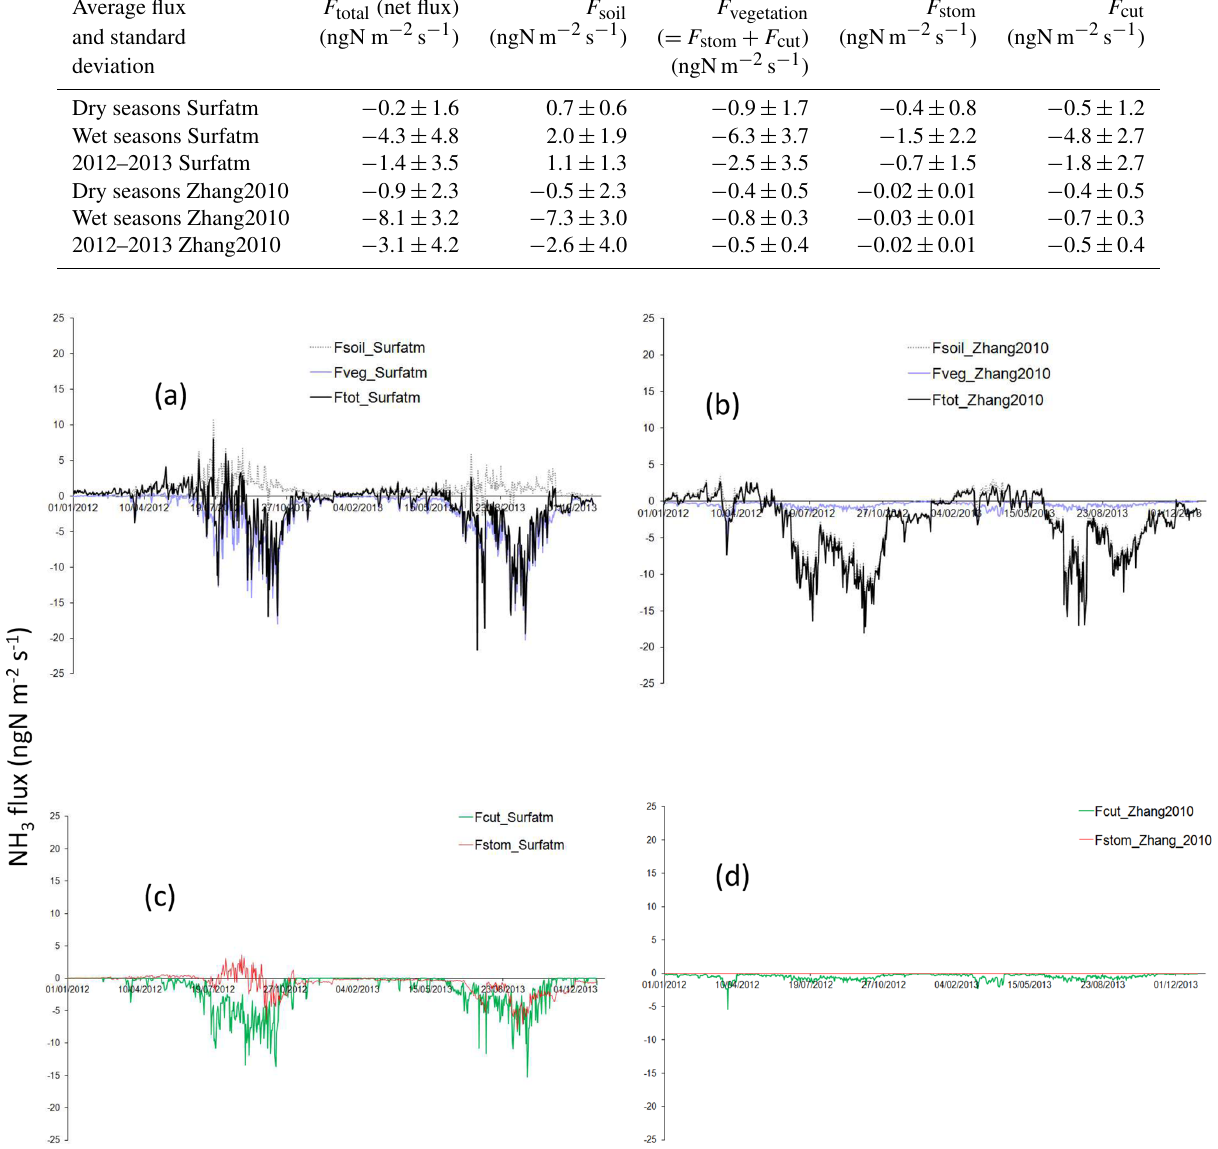
Figure 10. Daily NH 3 flux (ngNm − 2 s − 1 ) partitioned between soil and vegetation. The black line is for total net flux ( F tot ), the grey dashed line is for soil flux ( F sol ), and the blue line is for vegetation flux ( F veg ) for Surfatm in (a) and for Zhang2010 in (b) . The red line is for stomatal flux ( F stom ) and the green line is for cuticular flux ( F cut ) for Surfatm in (c) and for Zhang2010 in (d)